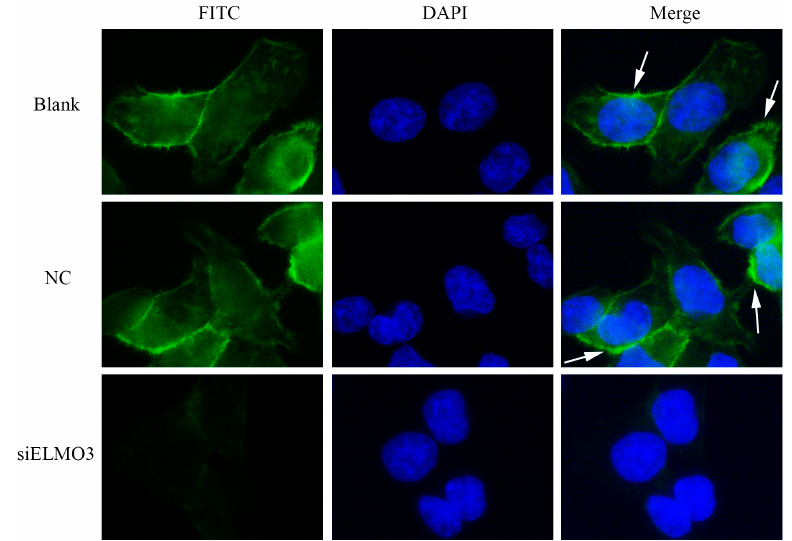
Figure 6. Knockdown of ELMO3 inhibited the F-actin polymerization of HCT116 cells. The cytoskeleton and nuclei were stained with FITC-phalloidin and DAPI. The fluorescent signals of F-actin, labeled white arrows, were detected on the plasma membrane in the NC and Control groups. The representative photographs are shown at 400× magnification.